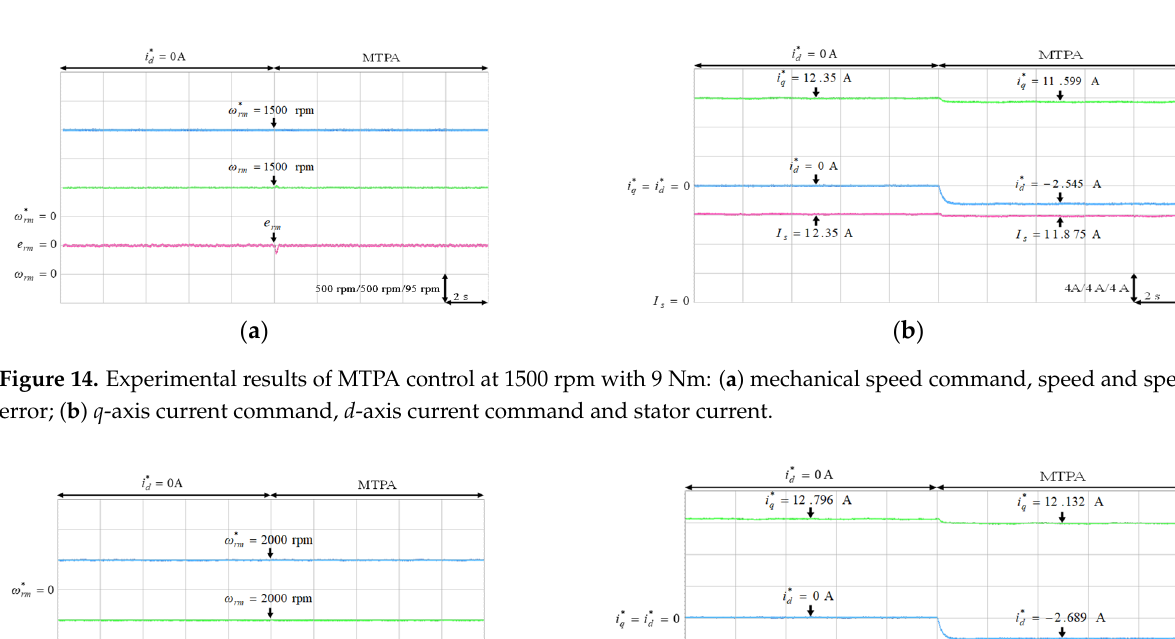
Figure 13. Experimental results of MTPA control at 1500 rpm with 6 Nm: ( a ) mechanical speed command, speed and speed error; ( b ) q -axis current command, d -axis current command and stator current.